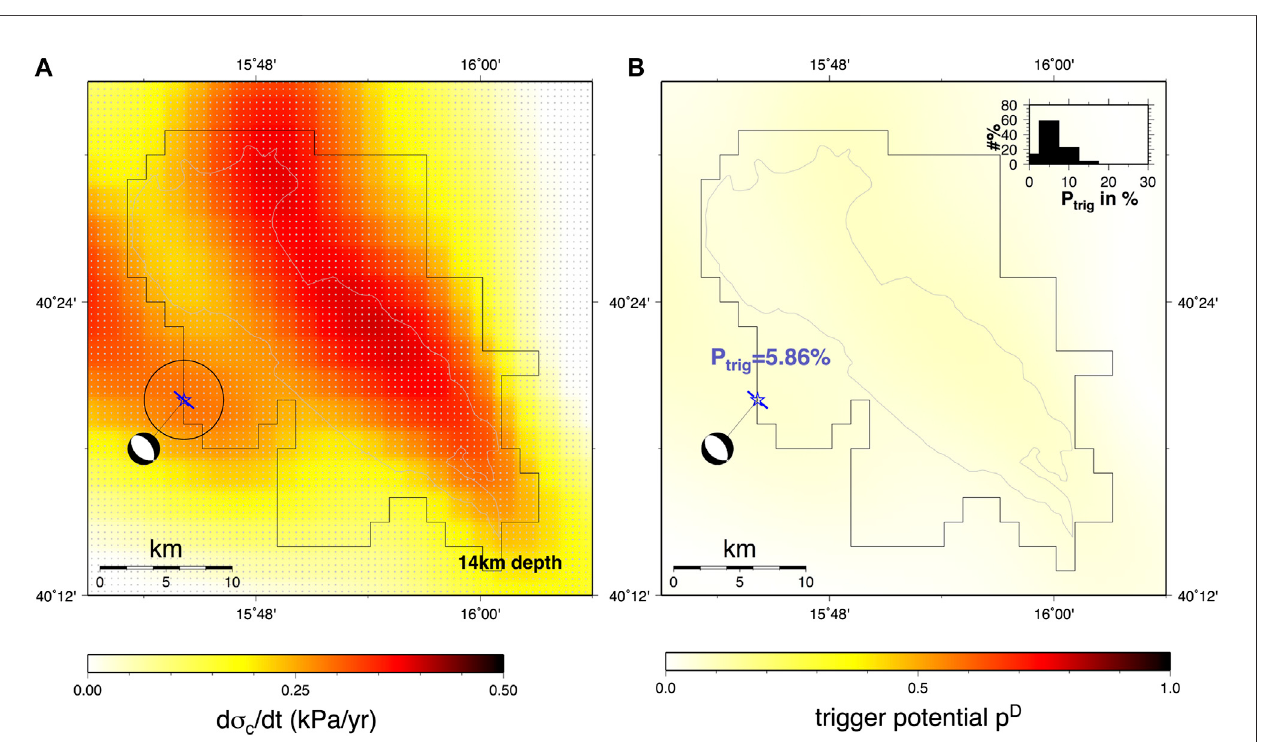
FIGURE5 | (A) Coulombstressratemodeland (B) triggerpotentialatadepthof14kmfromthedepletionoftheVald ’ Agrioil fi eld.Centroidlocation(star),bestdouble couple moment tensor and preferred plane dipping to SW identi fi ed from the directivity analysis (blue line) are shown. Epicenter location uncertainties following Garcia- Aristizabaletal. (2020)(blackopencircle)areshown in (A) . Vald ’ Agriconcession and theoutlineofthewater oilcontactareindicatedwithblack and greylines,respectively.